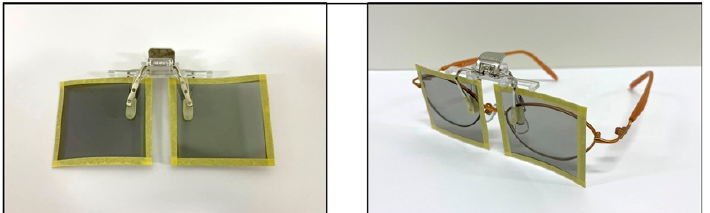
Figure 2. The polarizing film attached to the eyeglasses. The film can be easily attached to the eye- glasses using a clip.